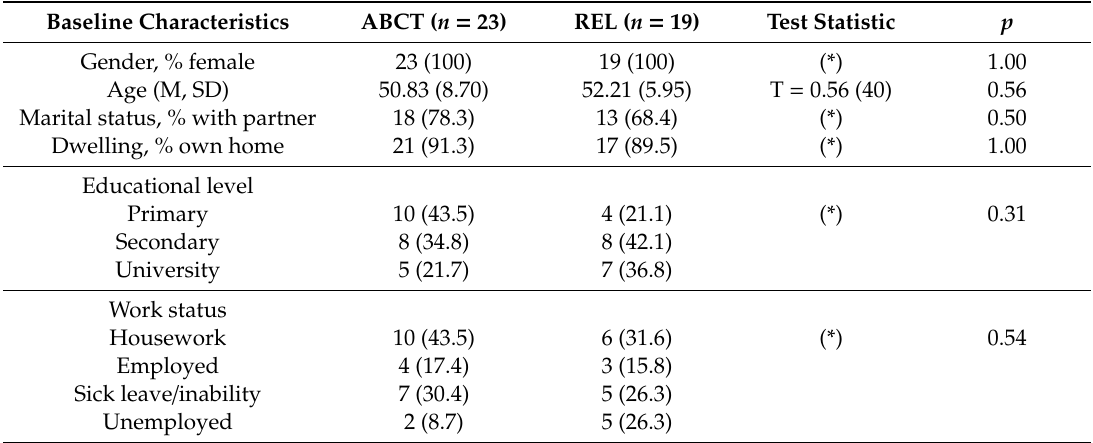
Table 2. Baseline sociodemographic and clinical features of FM patients by study arm